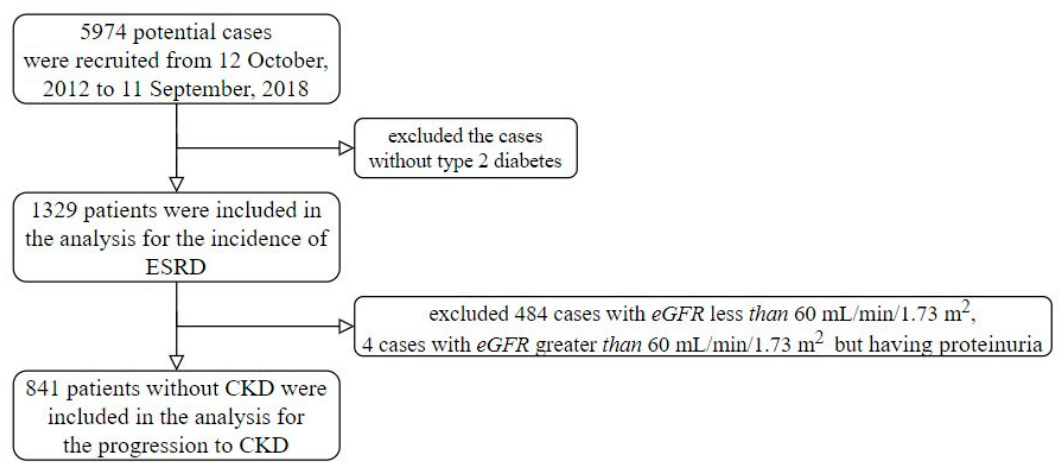
Figure 1. Recruitment process flow chart .